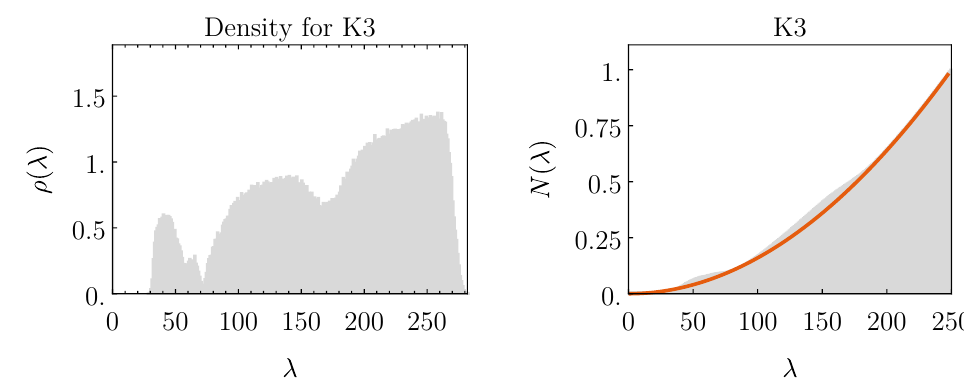
Figure 5 . On the left, we show the eigenvalue density for the Laplacian on K3 surfaces drawn from an ensemble of 1,000 samples in complex structure moduli space with each sample containing the lowest-lying 200 eigenvalues. On the right, we show the integrated eigenvalue density up to λ = 250 together with the asymptotic number of eigenvalues predicted by Weyl’s law (4.6) in